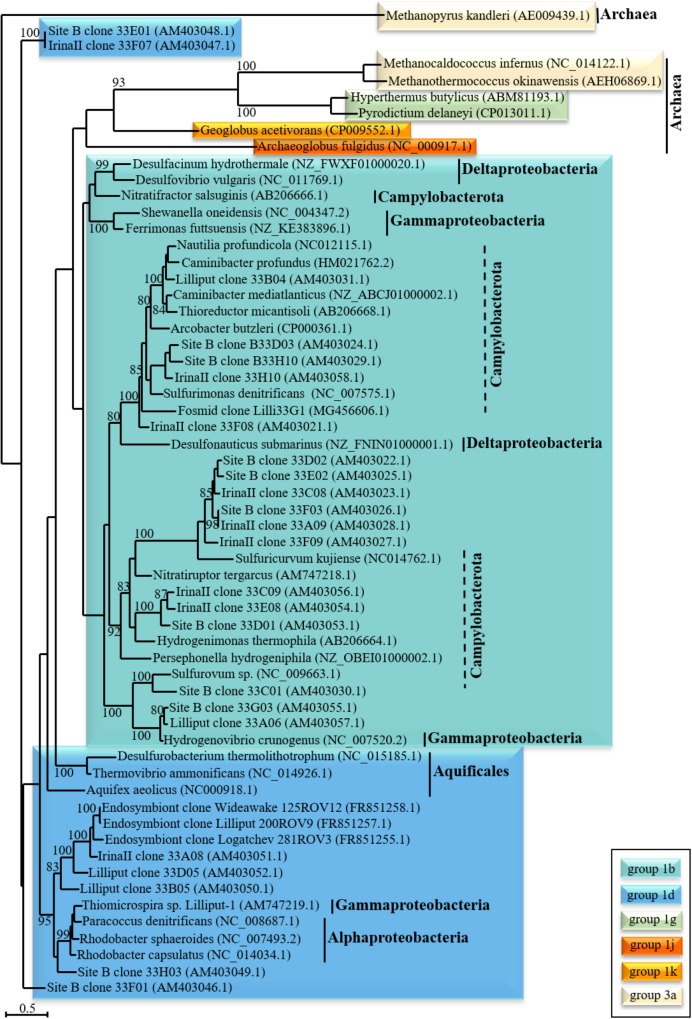
Phylogenetic relationship of “uptake” [NiFe]-hydrogenase large subunit structural genes. The phylogenetic tree was calculated for nucleotide sequences of the large subunit [NiFe]-hydrogenase genes of (primarily vent-derived) phylogenetically diverse Bacteria and Archaea. The scale bar denotes the number of substitutions per nucleotide position and bootstrap values are only indicated if greater than 80%. ClustalW alignments were performed prior to tree calculation using BioEdit (Hall, 1999) with the standard settings. The tree was calculated using seaview (Gouy et al., 2010) with maximum likelihood analysis (four rate classes) and bootstrap values were calculated with 100 replicates. The classification of the [NiFe]-hydrogenase genes was determined using the HydDB web tool (Sondergaard et al., 2016).